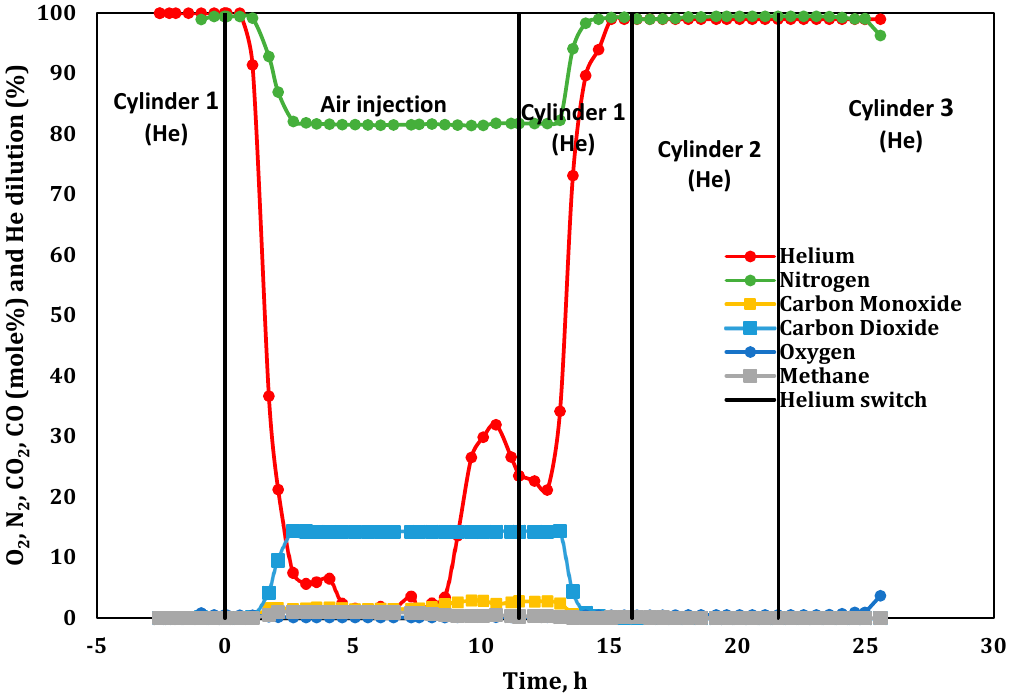
Figure 12. Produced combustion gas composition (recalculated) for the vuggy test.